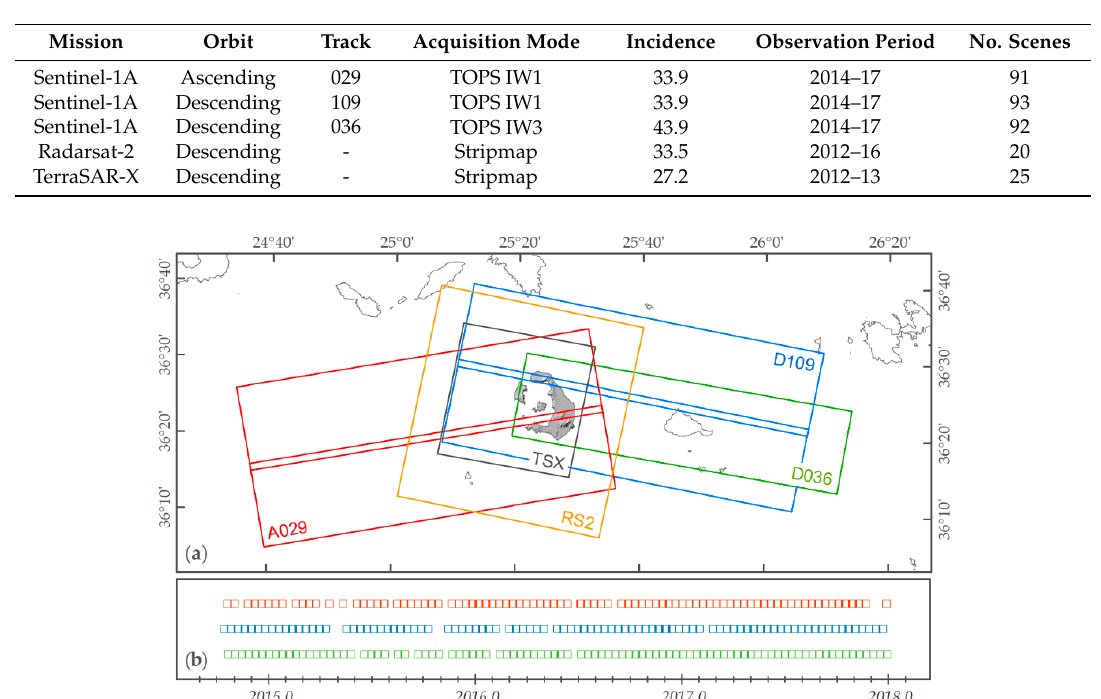
Figure 2. ( a ) Sentinel-1 IW burst coverage over Santorini volcano for the Sentinel-1 ascending 029 (A029), and descending orbits 109 (D109) and 036 (D036), and for Radarsat-2 (RS2) and TerraSAR-X (TSX) frames; ( b ) Temporal distribution of Sentinel-1 data for the A029, D109 and D036 acquisition geometries. Table 1. Overview of SAR data in-use.